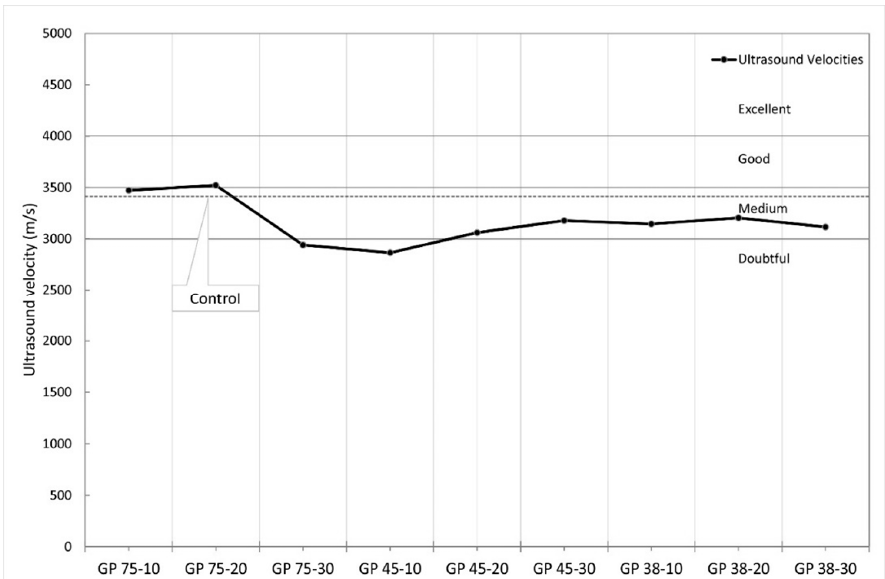
Figure 7. Ultrasonic pulse test results.